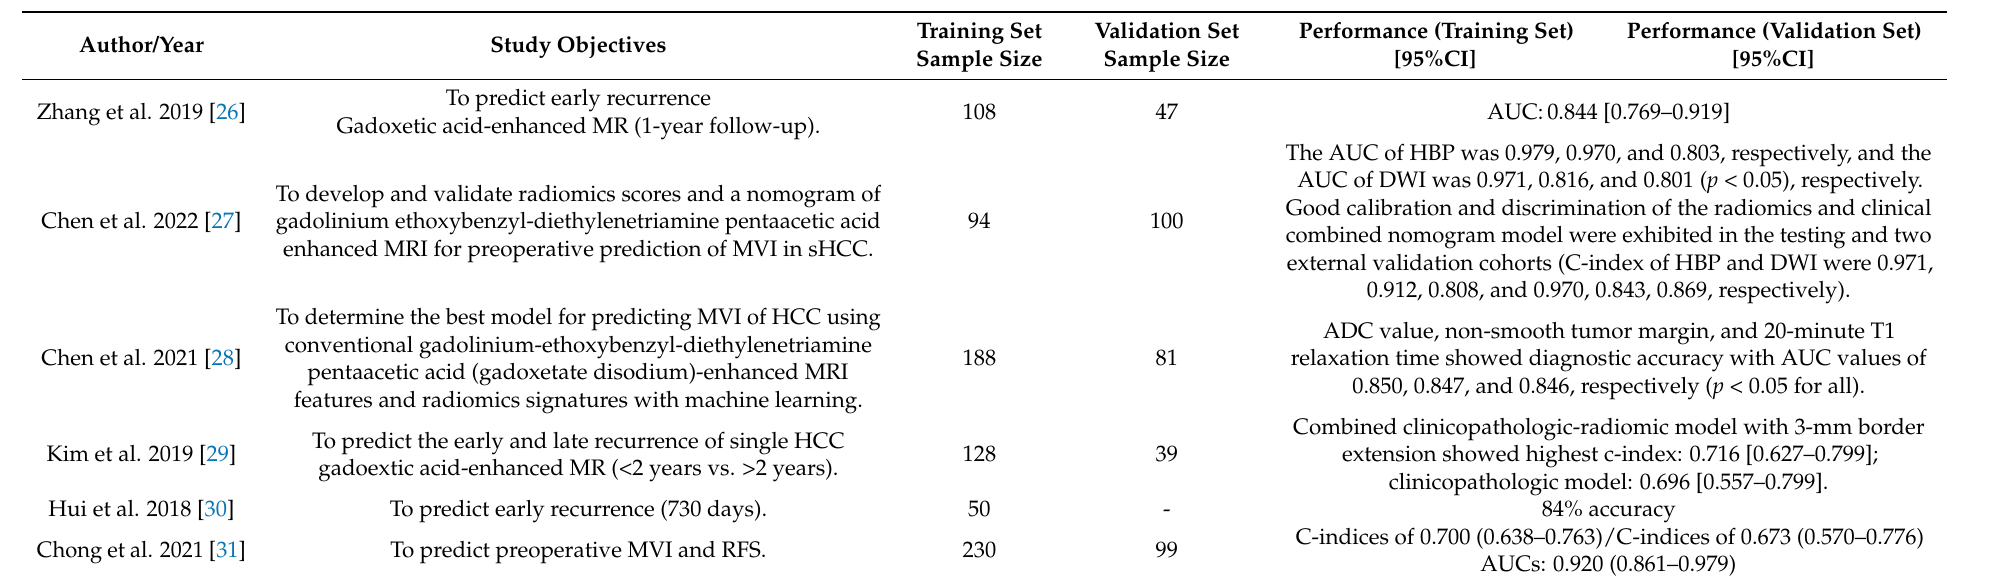
Table 3. Performance of radiomics approaches (using MR features to predict patient